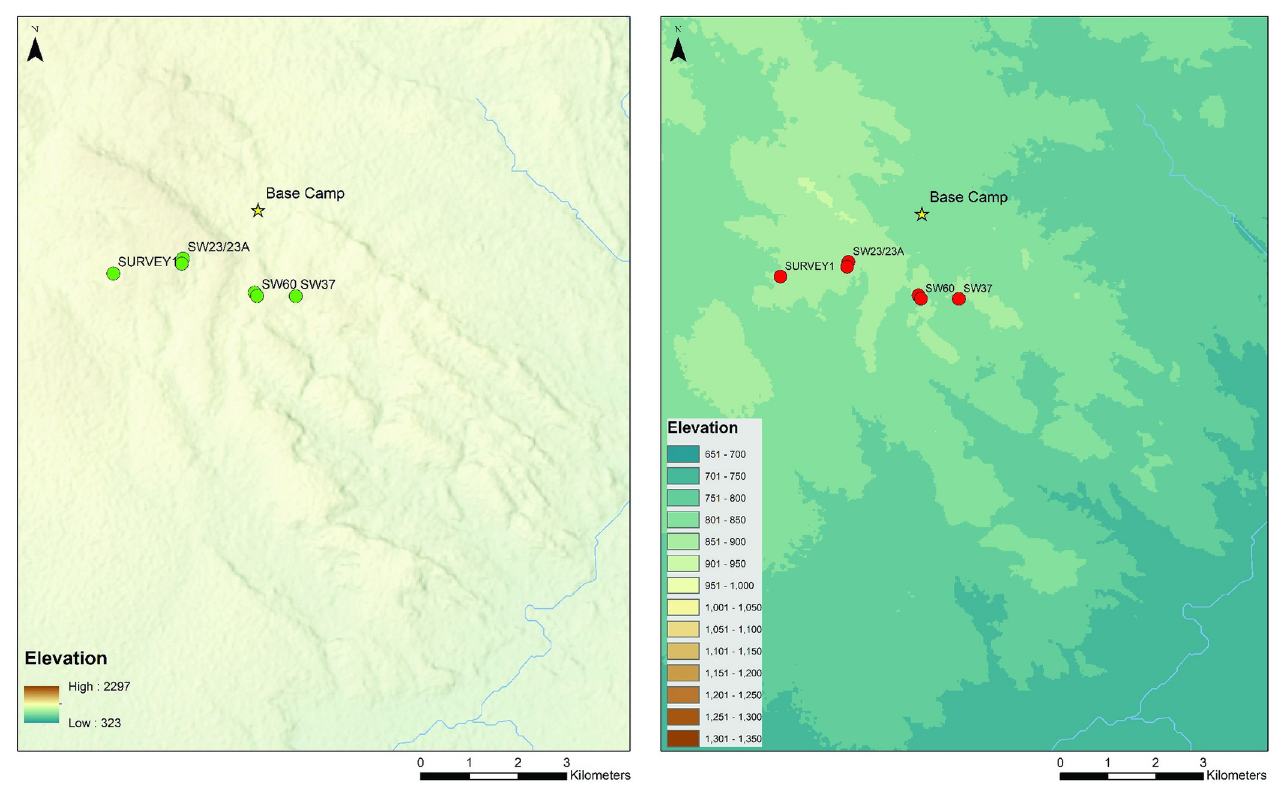
Fig 6. Phase 2 stratified archaeological survey localities (2016, 2019). SRTM digital elevation map reprinted from USGS EROS (Earth Resources Observatory and Science (EROS) Center) (public domain): http://eros.usgs.gov/#.